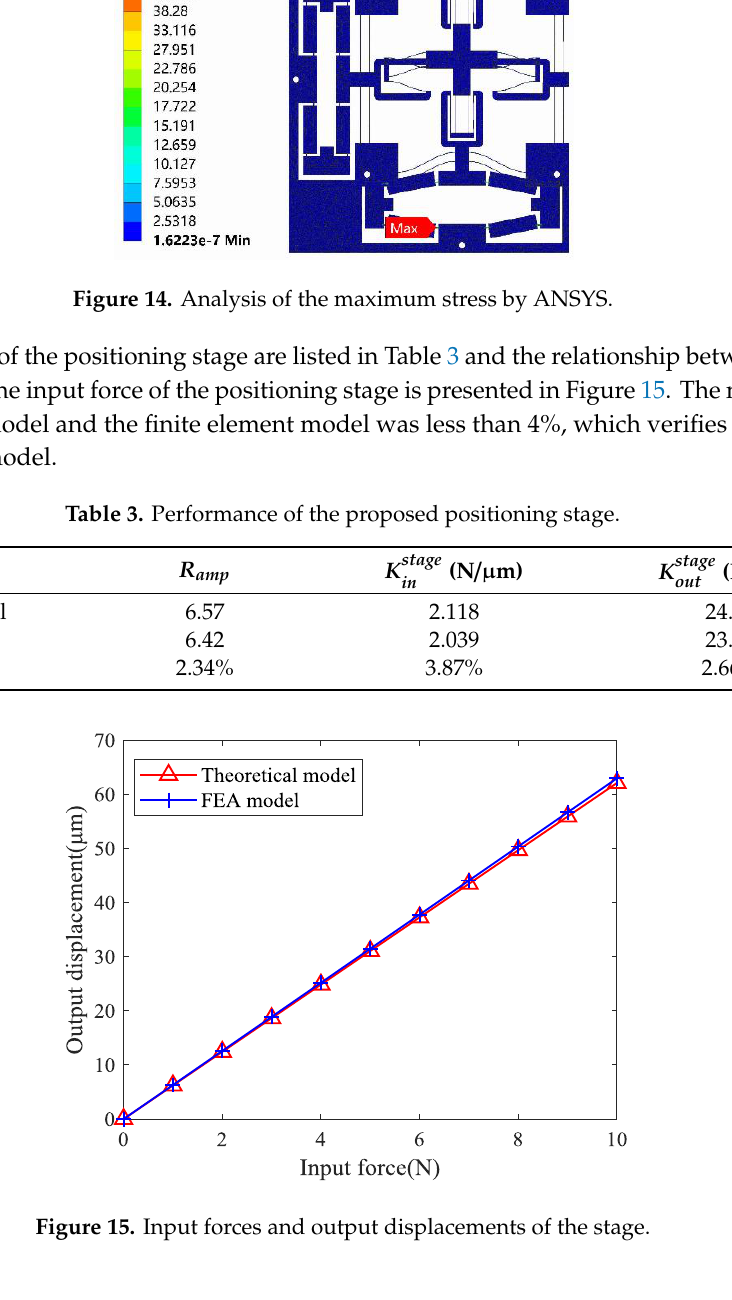
( f ) Figure 16. Modal analysis of the stage by ANSYS: ( a ) 44.234Hz, ( b ) 44.335Hz, ( c ) 88.232Hz, ( d ) 88.393Hz, ( e ) 98.418Hz, and ( f ) 98.539Hz. 5. Experiment Setup